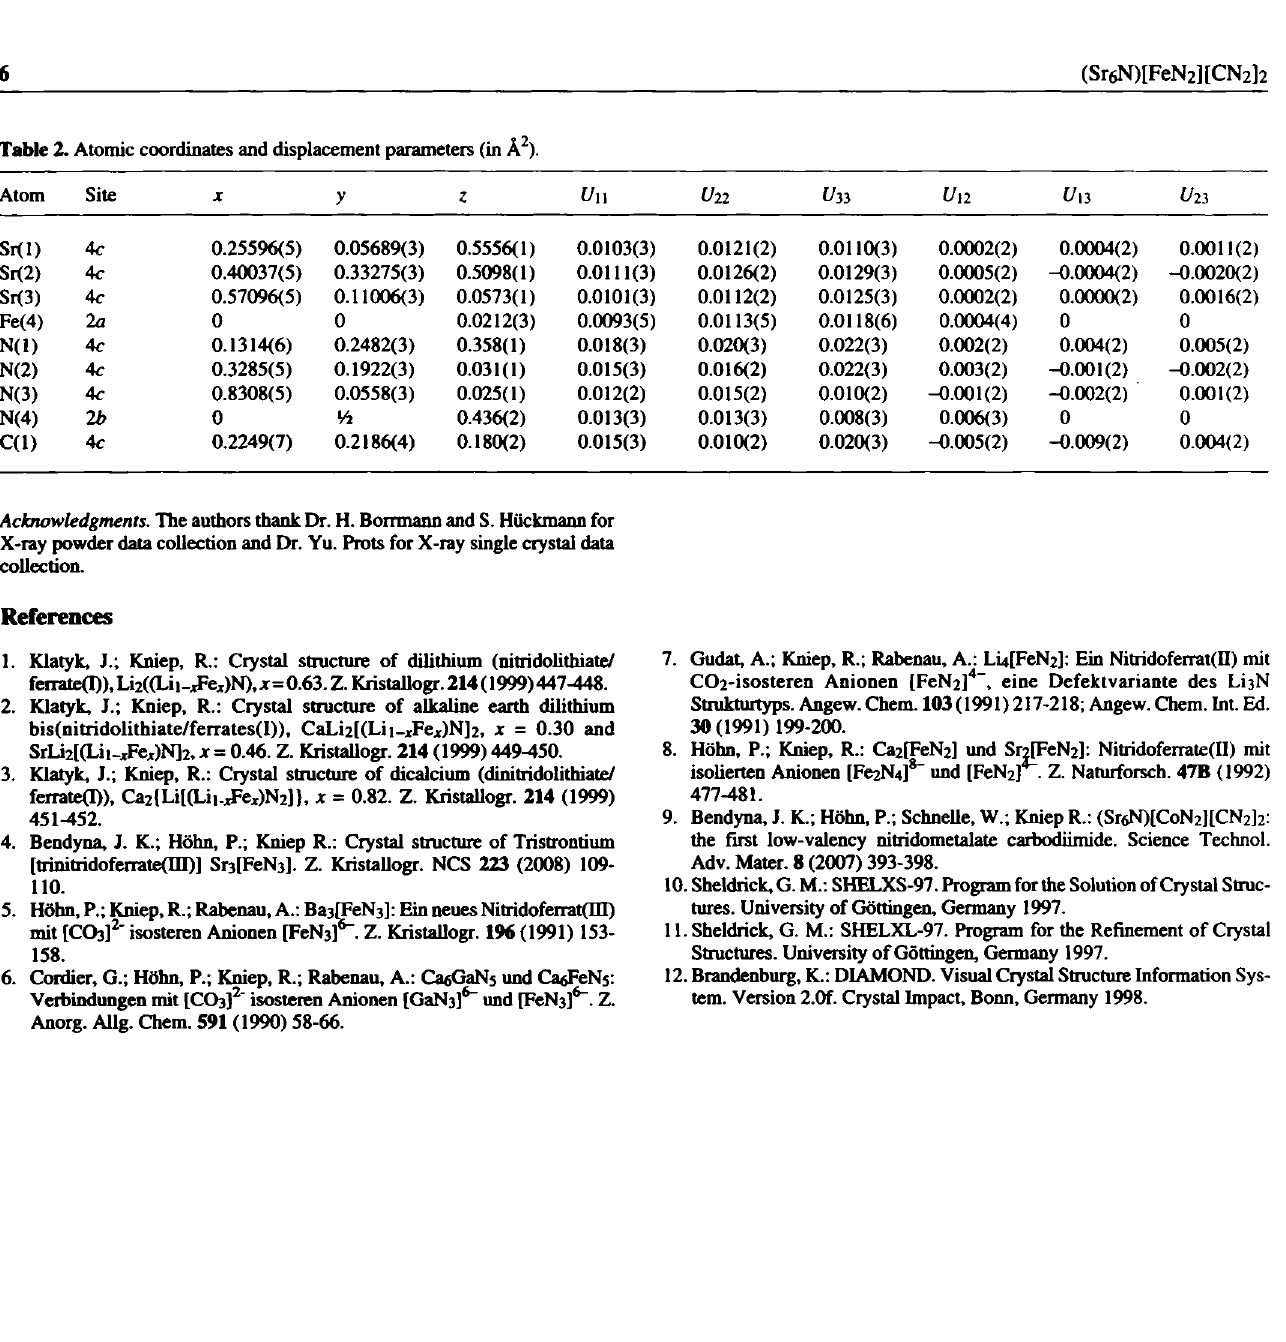
Table 2. Atomic coordinates and displacement parameters (in Â 2